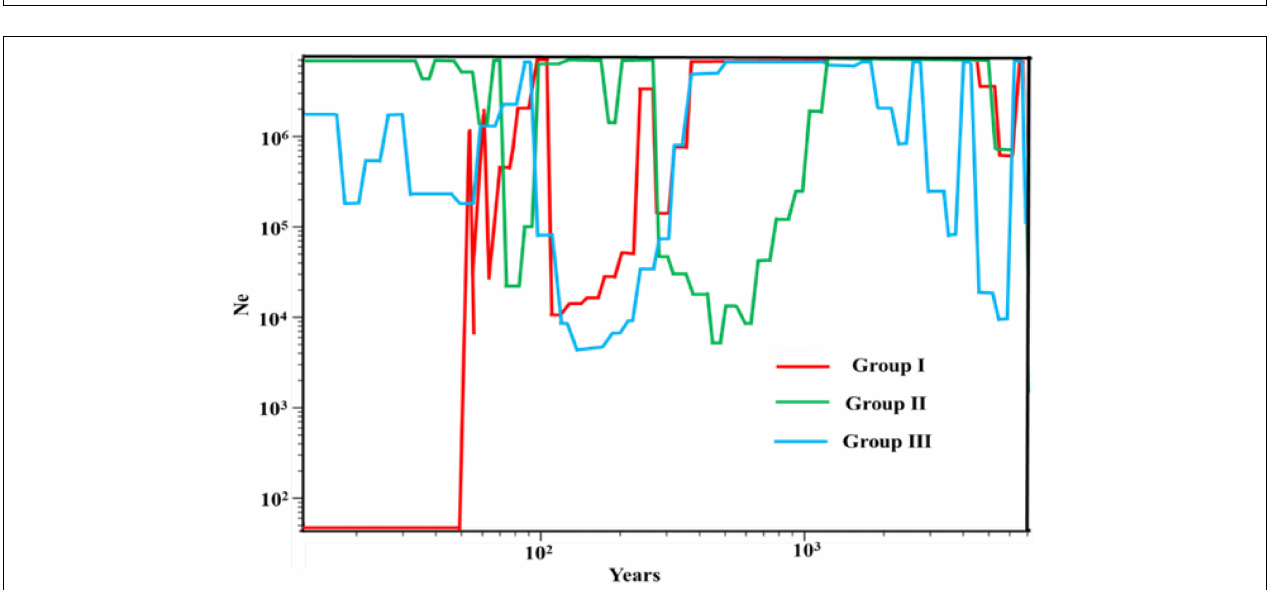
during 16 ∼ 5.92 Ma that led to the differentiation of these groups may be QTP uplift in 13 ∼ 7 Ma (Harrison et al., 1992; Willis and McElwain, 2014). During the uplift of the QTP